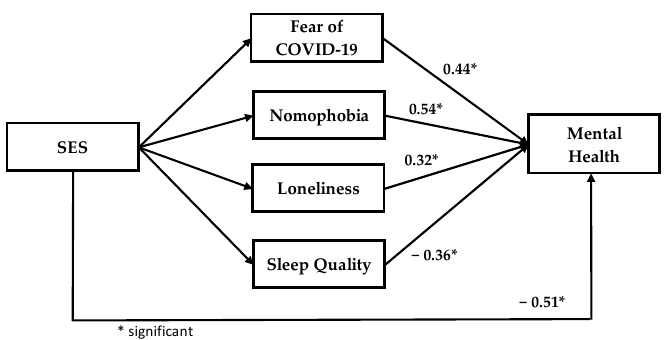
Figure 3. Output of mental health model (general students).